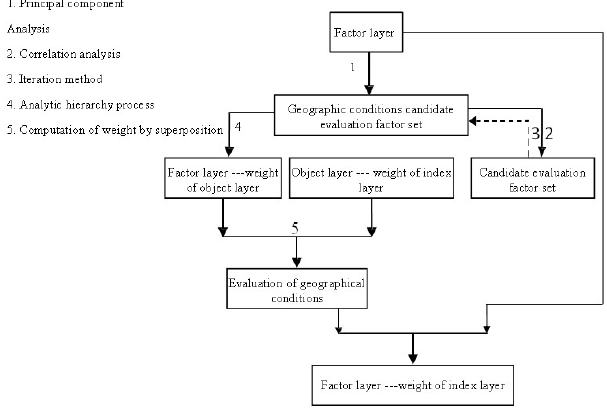
Figure 2. Evaluation